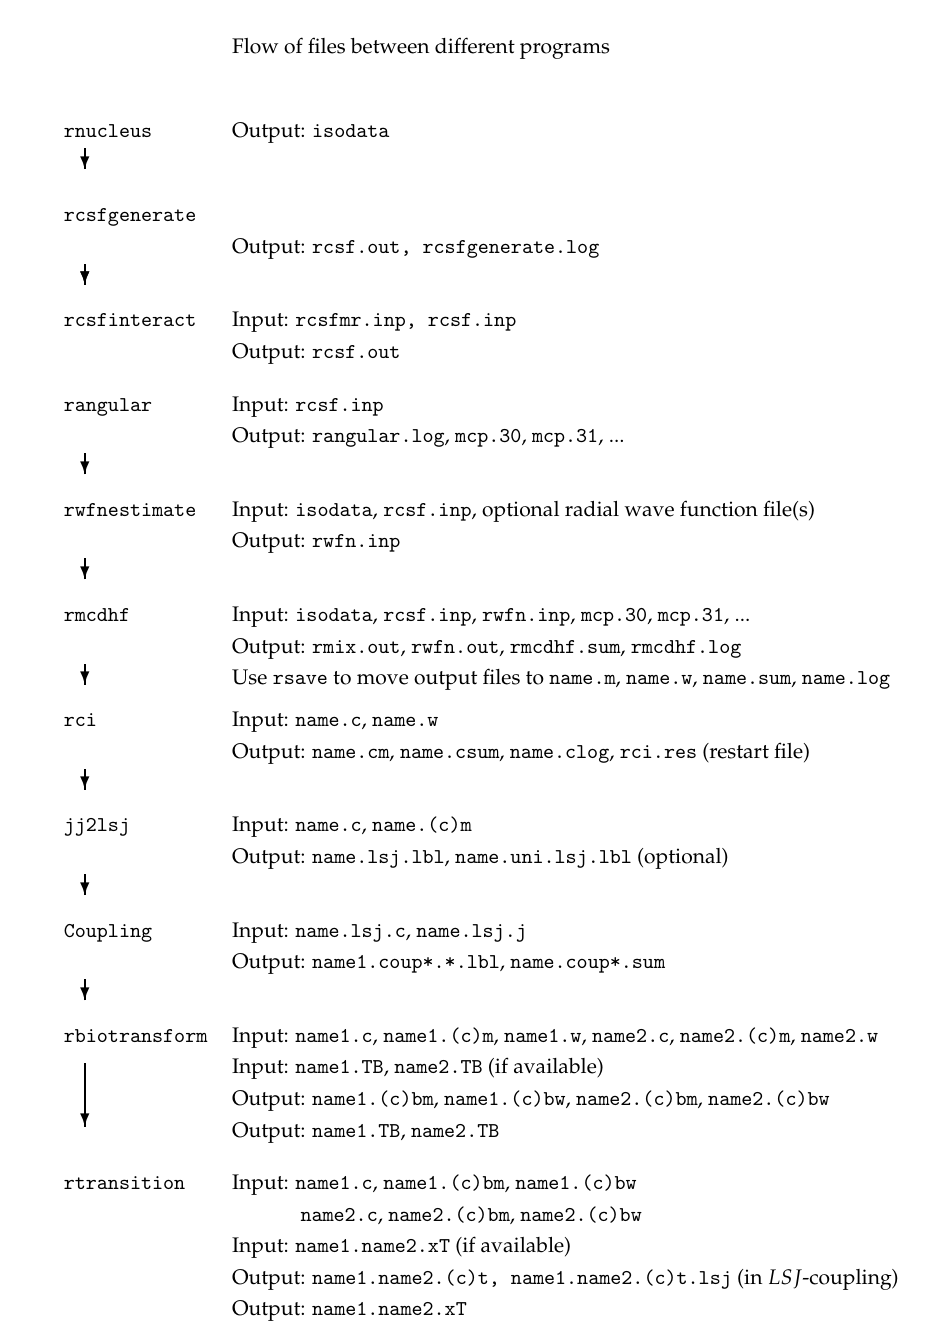
Figure 2. Flow of files for a normal sequence of program runs. Extensions (c) indicate data files based on rci mixing coefficients. For rtransition the extension x denotes the